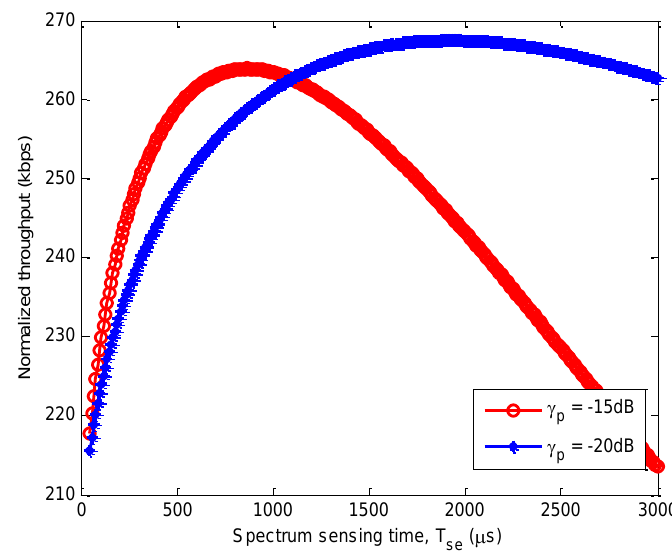
Figure 10. The normalized throughput under different sleeping durations and spectrum sensing durations.